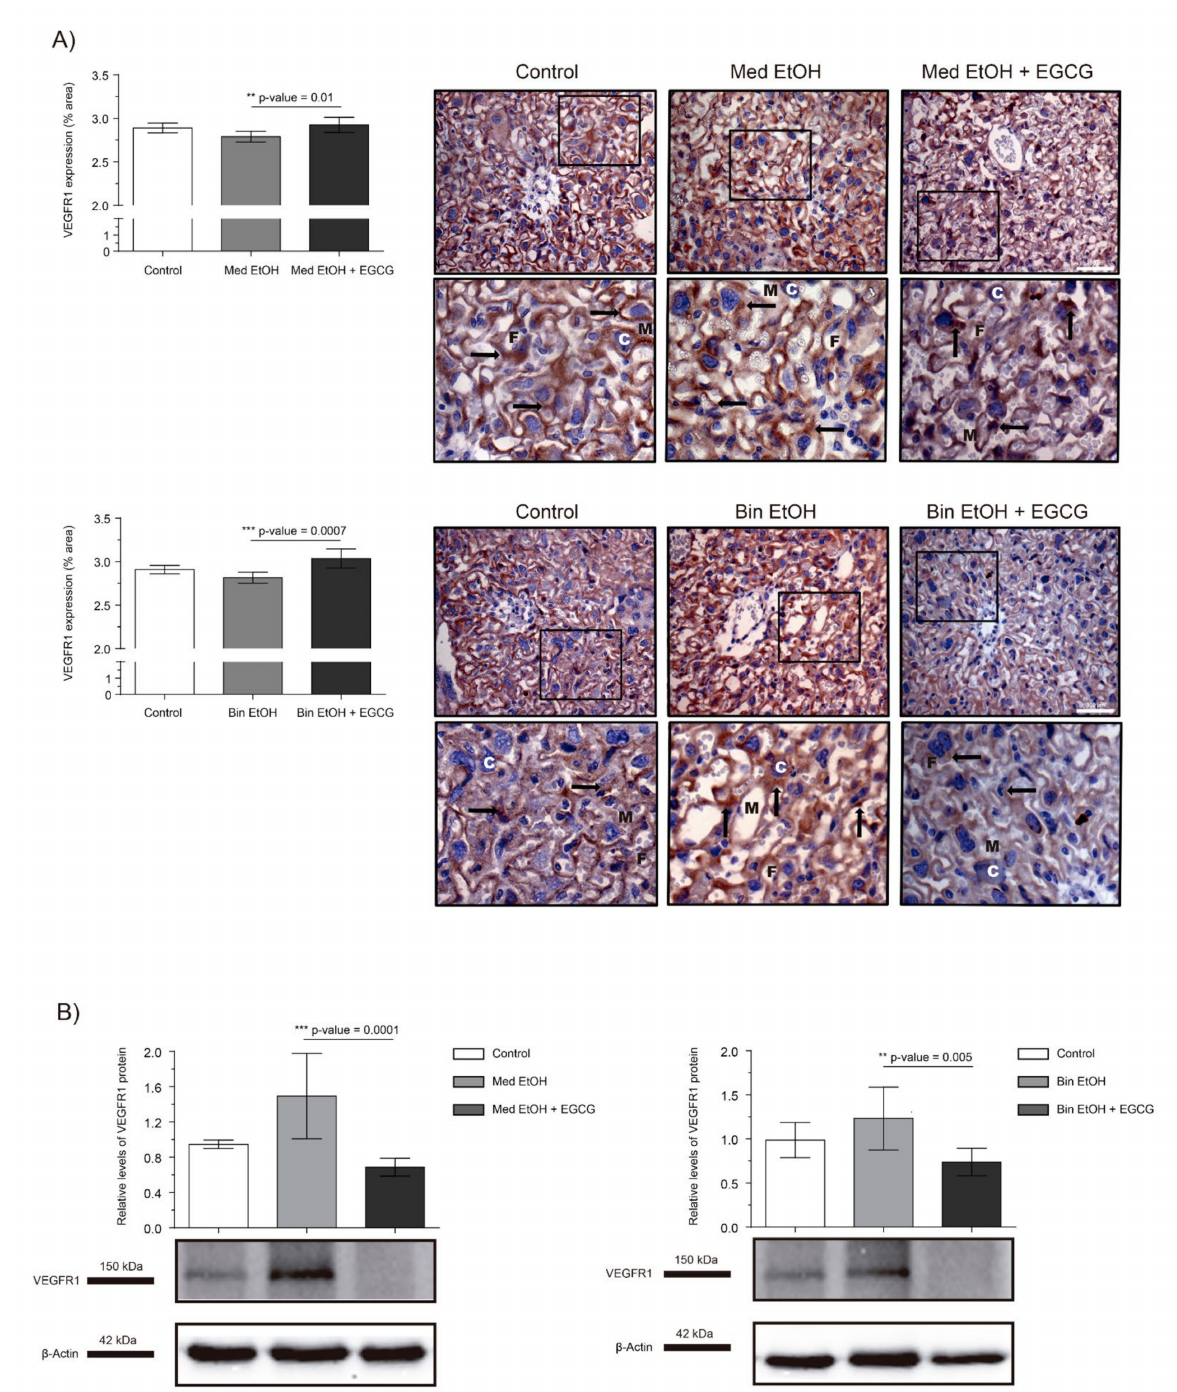
Figure 4. Representative vascular endothelial growth factor receptor 1 (VEGF-R1) immunostaining in placenta sections ( A ) and Western blot VEGF-R1 protein analysis in placental lysed samples ( B ) for PAE and EGCG treatment binge and Mediterranean experimental conditions. ( A ) Boxed sections in VEGF-R1 immunostaining are shown an enlarged image of the labyrinth zone. VEGF-R1 quantification in placental sections in two different fields (40 × ) per section. ( B ) Representative Western blot of VEGF-R1 expression observed in all samples analyzed for the different experimental conditions. Protein levels were normalized using α -tubulin as load control. Arbitrary units express “fold change”. At least five samples from different litters were used in each group. Kruskal–Wallis test (Dunn’s test for multiple comparisons) was used for inter-group comparisons. Asterisks denote the level of significance: ** p -value < 0.01, *** p -value < 0.005. M: maternal blood; F: fetal blood; C: cytotrophoblast; arrows VEGF-R1 positive